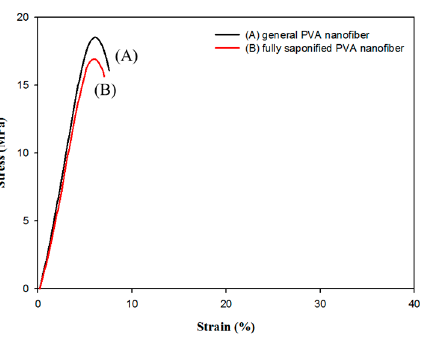
Figure 10. ( A ) A partial proton nuclear magnetic resonance spectrum of fully saponified PVA nanofibers; ( B ) Partial Fourier transform infrared spectroscopy spectra for un-saponified PVAc nanofibers (orange) and fully saponified PVA nanofibers (red). The polymer concentration was kept constant at 15 wt % and the saponification solution was comprised of NaOH (10 g), Na 2 SO 4 (10 g), MeOH (10 g), and H 2 O (100 g). The saponification temperature was 25 °C, the saponification time was 30 h, and DS was 99.93%.